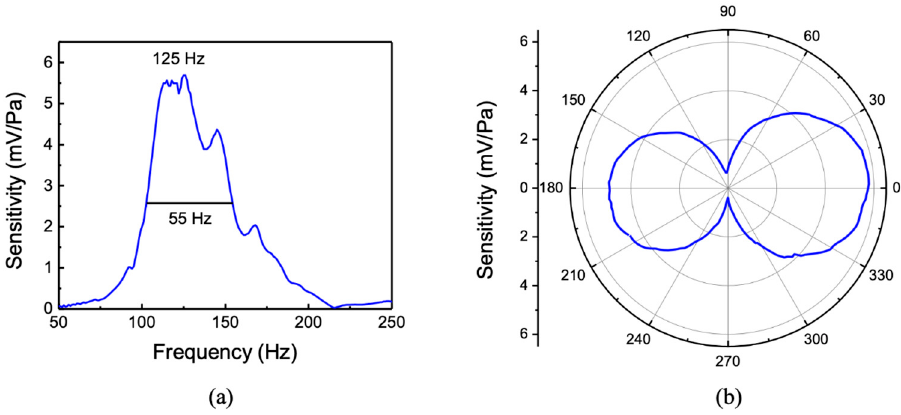
Figure 6. ( a ) Frequency responses and ( b ) directional response operating in an underwater environment.